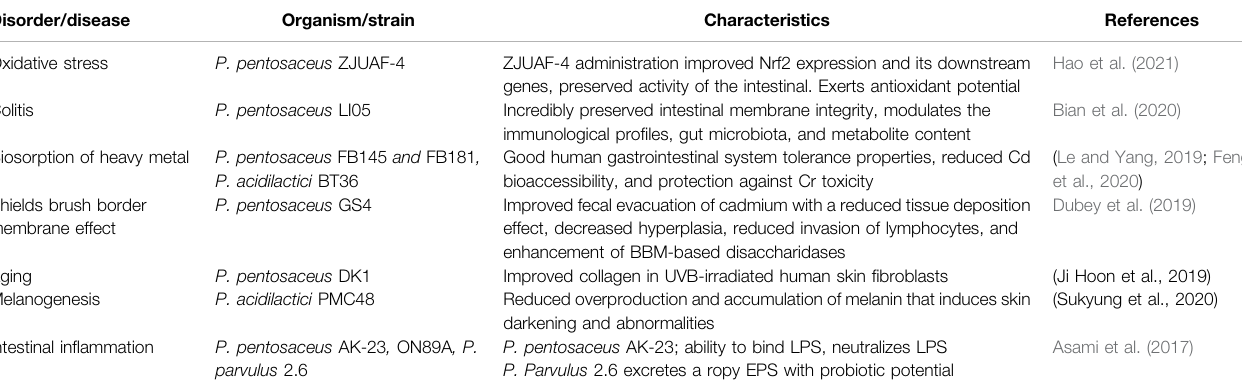
TABLE 3 | Application of Pediococcus in health-related conditions.